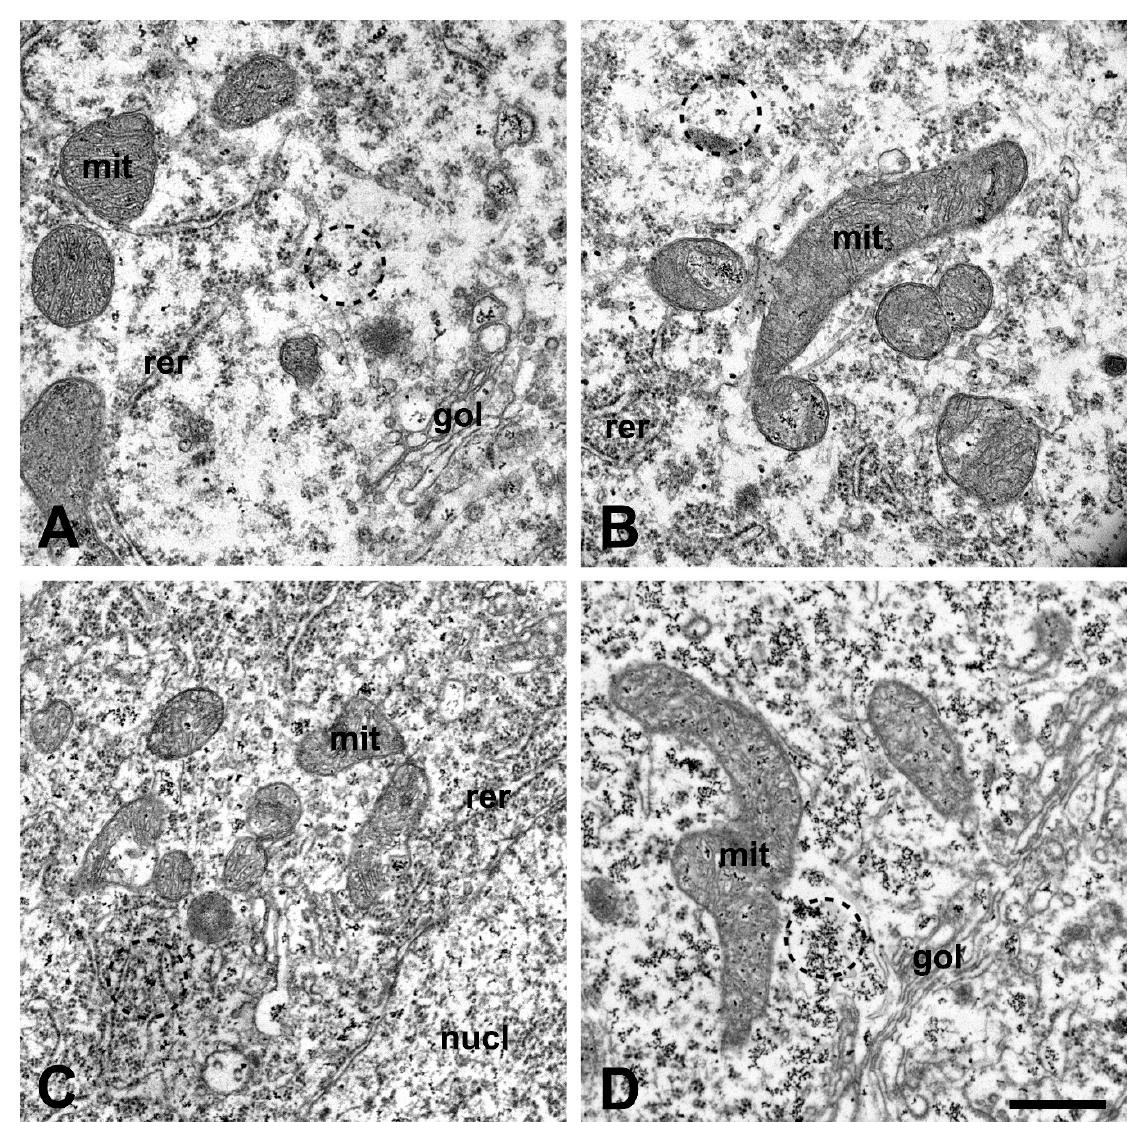
Figure 3. No ultrastructural alterations can be seen in untreated ( A ) and healthy-serum-treated motor neurons (MNs) ( B ). The dilated lumen of the endoplasmic reticulum and mitochondrial cristae structure characterize the micrographs from mice treated with sera from amyotrophic lateral sclerosis (ALS) patients with superoxide dismutase 1 pLeu144Phe mutation ( C ) and chromosome 9 open reading frame 72 hexanucleotide repeat expansions ( C9ORF72 HNRs) ( D ). In the motor neurons of ALS-sera-treated mice ( C , D ), an elevated number of electron-dense deposits (EDDs), representing the calcium content, can be seen compared to the MNs of untreated ( A ) and healthy-sera-treated animals ( B ). The elevation in the numbers of EDDs was most prominent in the group treated with sera from ALS patients with C9ORF72 HNRs ( D ). For representative images from the other groups, see Figure S2. Mit: mitochondrion; rer: rough endoplasmic reticulum; gol: Golgi complex; nucl: nucleus. Scale bar: 500 nm.